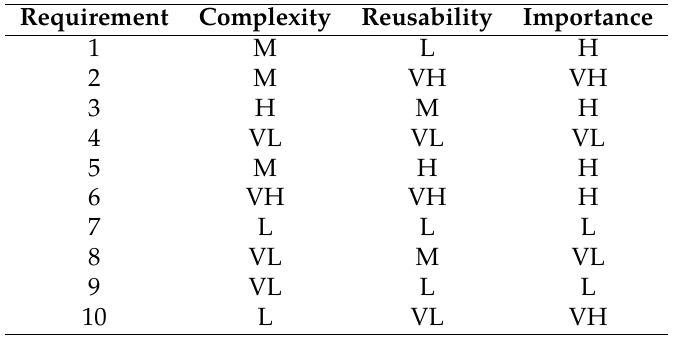
Table 4: Result of aggregating the five opinion’s matrices using the MLIOWA operator